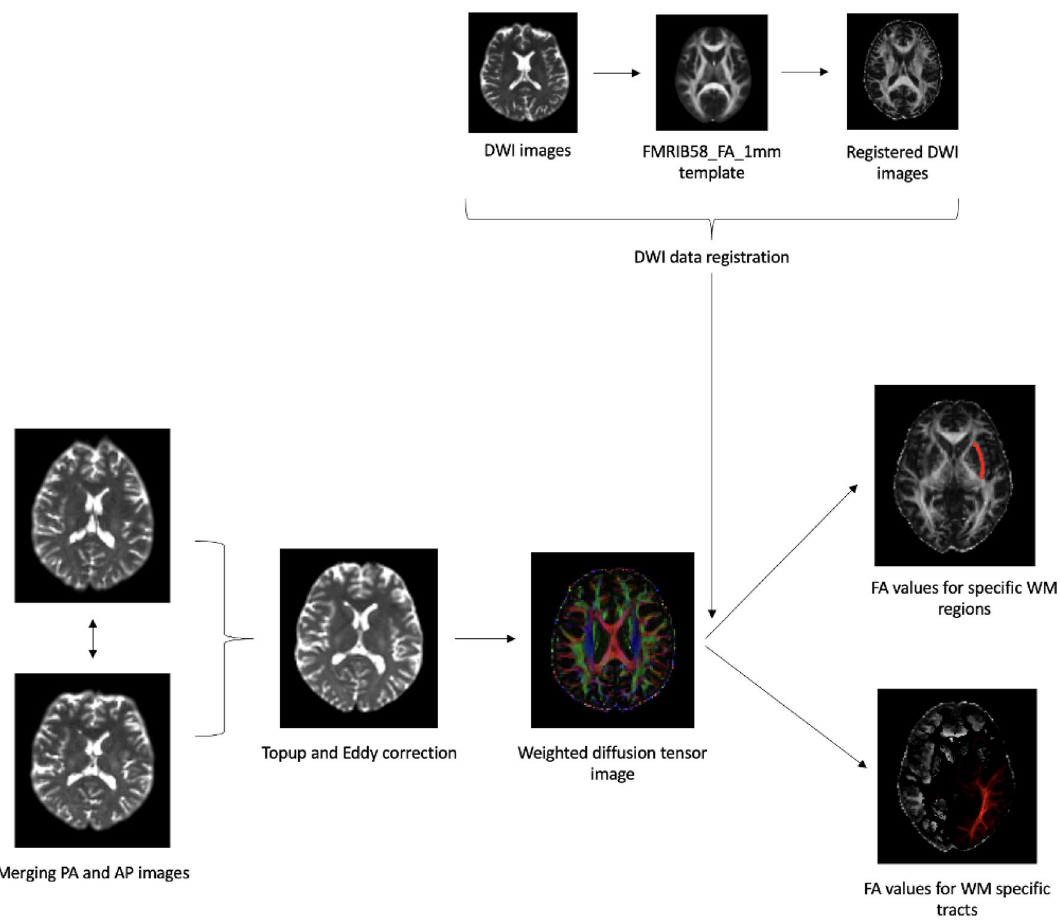
Figure 3. Graphic presentation of the MRI diffusion data processing steps. PA posterior–anterior, AP anterior– posterior, DWI diffusion weighted imaging, FA fractional anisotropy, WM white